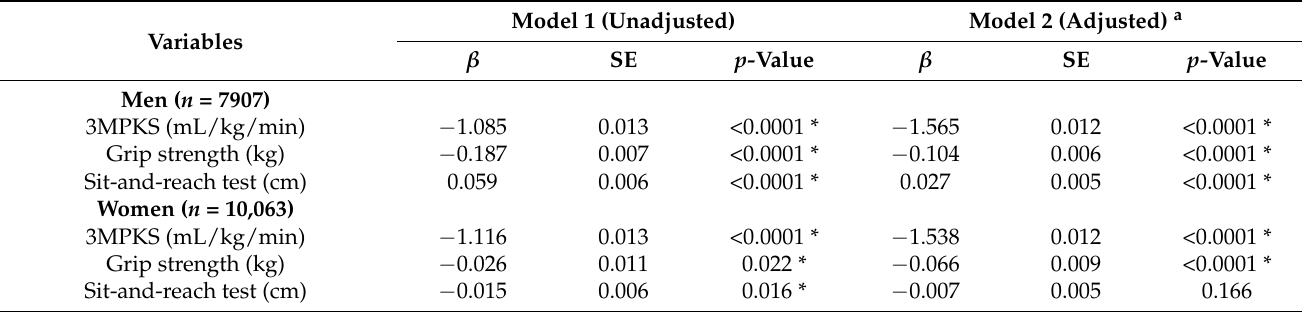
Table 3. Multiple linear regression coefficients for predicting body fat percentage using different physical fitness